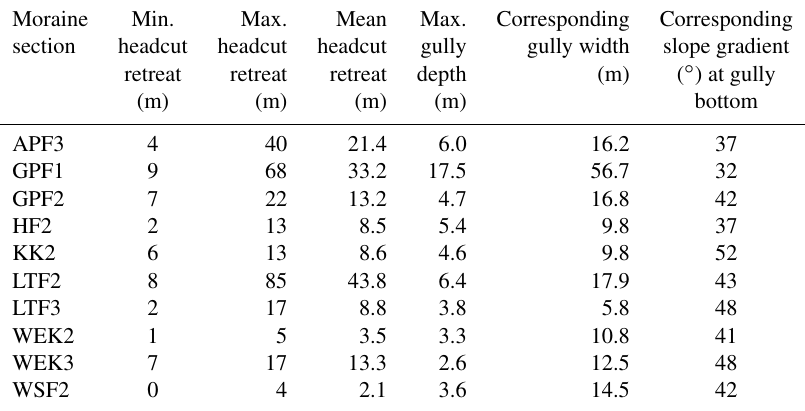
Table 5. Headcut retreat minima, maxima, and mean values between 1953, 1954, or 1959 (oldest available DEM) and 2018 or 2019 (newest available DEM) for each gullied moraine section and maximum gully depth, corresponding gully width, and corresponding slope gradient at the gully bottom for the most deeply incised gully on the respective moraine section. Moraine Min. Max. Mean Max. Corresponding Corresponding section headcut headcut headcut gully gully width slope gradient retreat retreat retreat depth (m) ( ◦ ) at gully (m) (m) (m) (m) bottom APF3 4